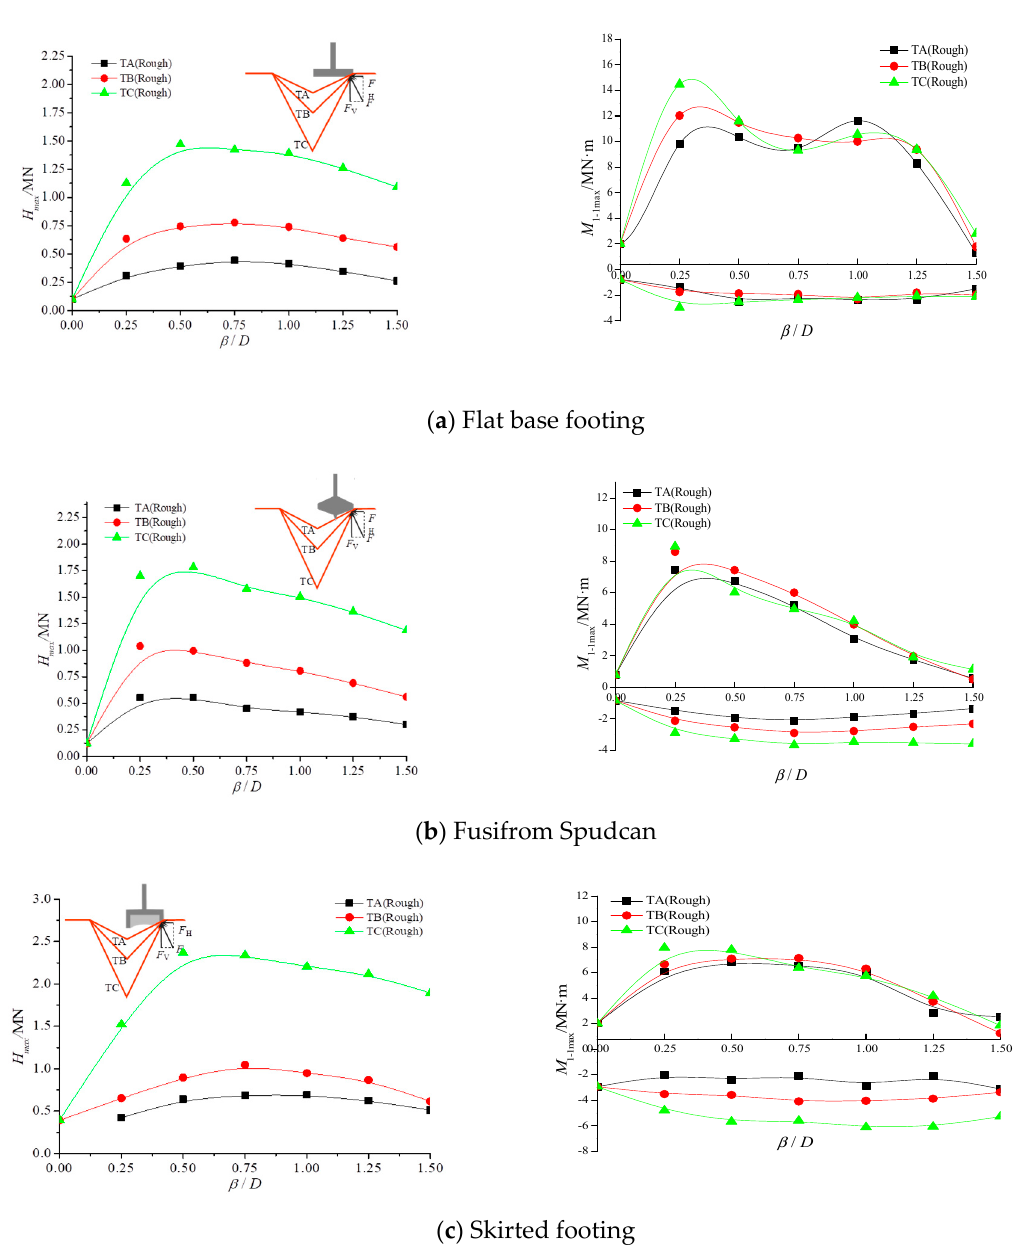
Figure 20. Maximum values of H and M against eccentricity ratio.